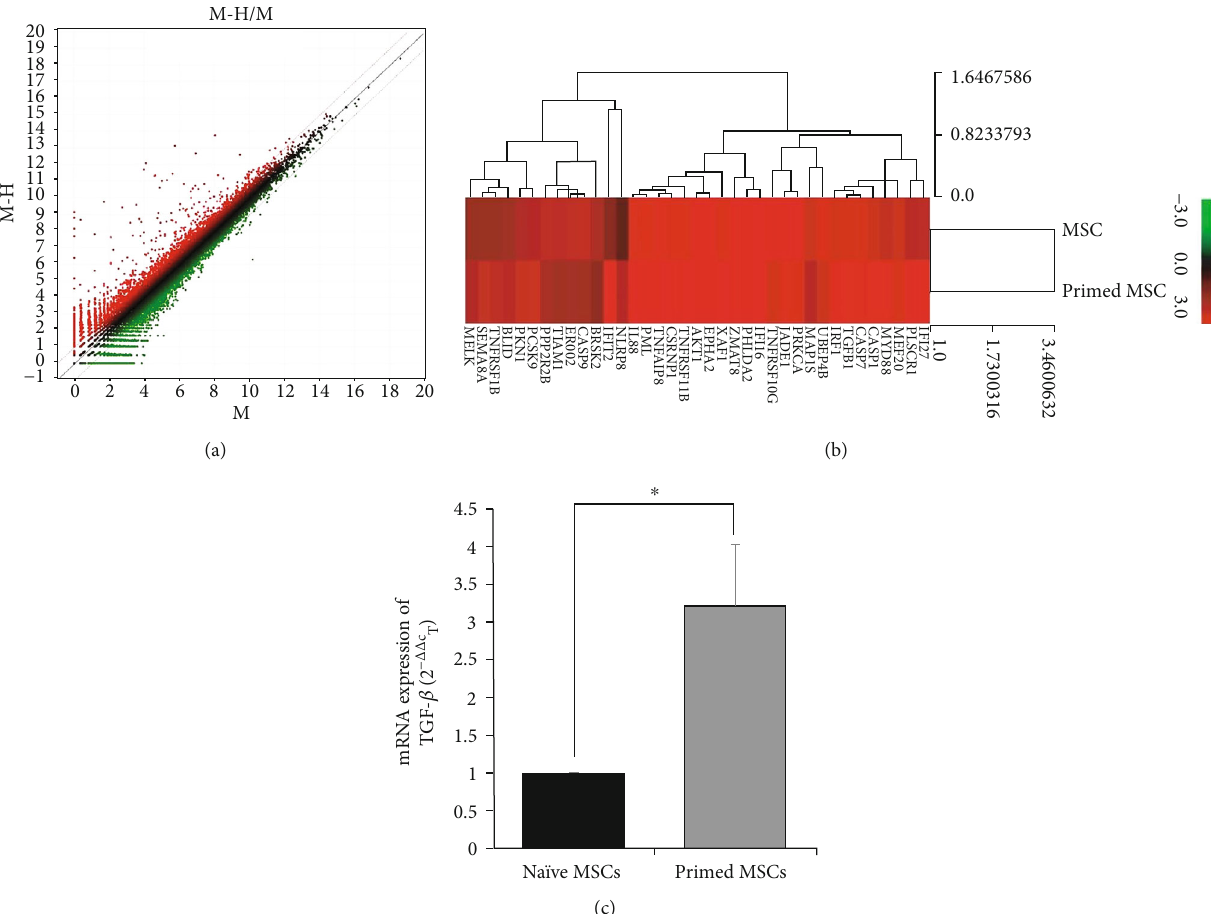
Figure 5: The mRNA expression patterns of primed MSCs. (a) Upregulated genes are represented in red and downregulated genes in blue. (b) Euclidean distance clustering of signi fi cant genes. (c) TGF- β expression in the naïve and primed MSCs analyzed by qPCR. The data are presented as the mean ± S : E : M . Three samples per experimental group were tested in each assay. ∗ p < 0 : 05